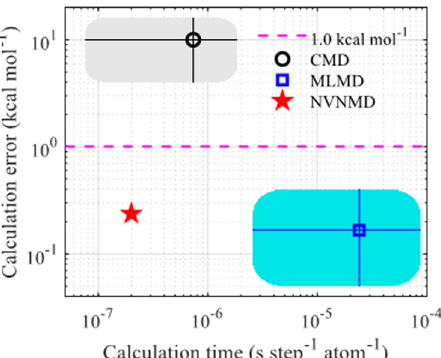
Fig. 4 Calculation time and error of CMD, MLMD, and the proposed NVNMD. The black circle, blue square and red star mark the points of ( μ t , μ e ), which are fetched from Table 1 and Table 5; the error bars and gray/blue regions are used to schematically illustrate the variations of data generated by different researchers; the horizontal dashed line is the quantum chemistry accuracy threshold, i.e., 1.0 kcal mol − 1 , 63 , 64 . Note: (1) we use μ e values in Table 1, in order to cover more results from literature, which are based on different datasets; (2) for more rigorous accuracy analysis based on identical datasets, please refer to Tables 2 and